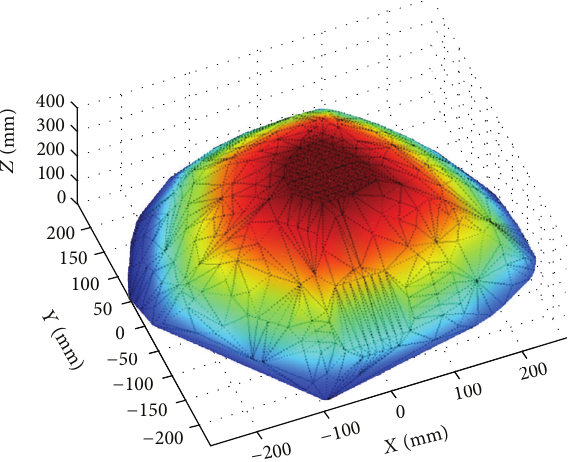
Figure 6: The simulated workspace of the robot in